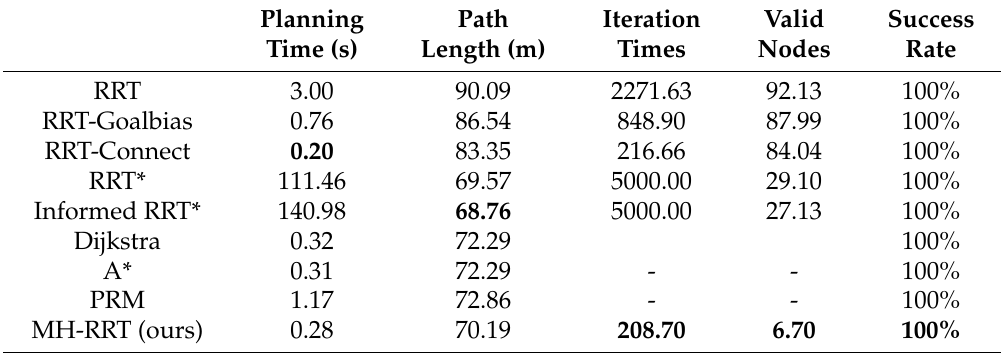
Table 1. Experiment